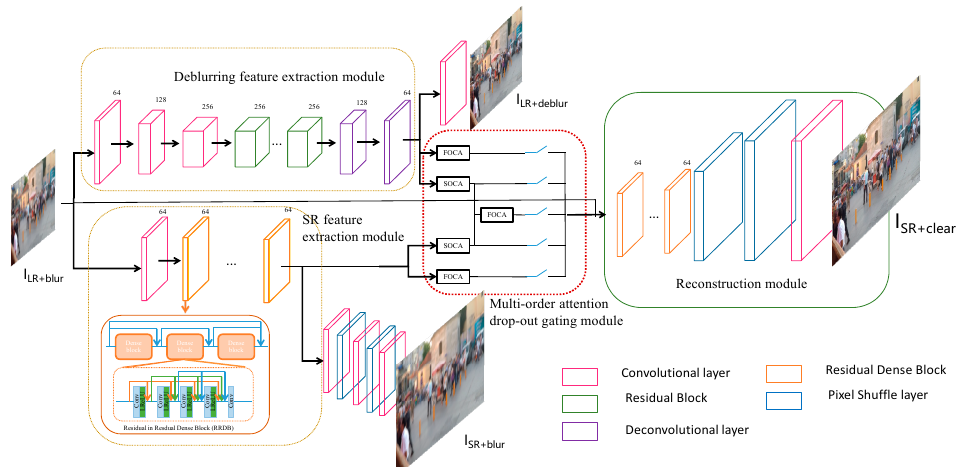
Figure 2. The overall architecture of the proposed model. Our model mainly contains four modules—deblurring feature extraction, SR feature extraction, multi-order attention drop-out gating, and reconstruction. An LR and blur input image is first passed through the separate SR and deblurring branches to obtain the decoupled features; then, they go through a multi-order attention drop-out gating fusion, before being reconstructed to output a super-resolved and clear